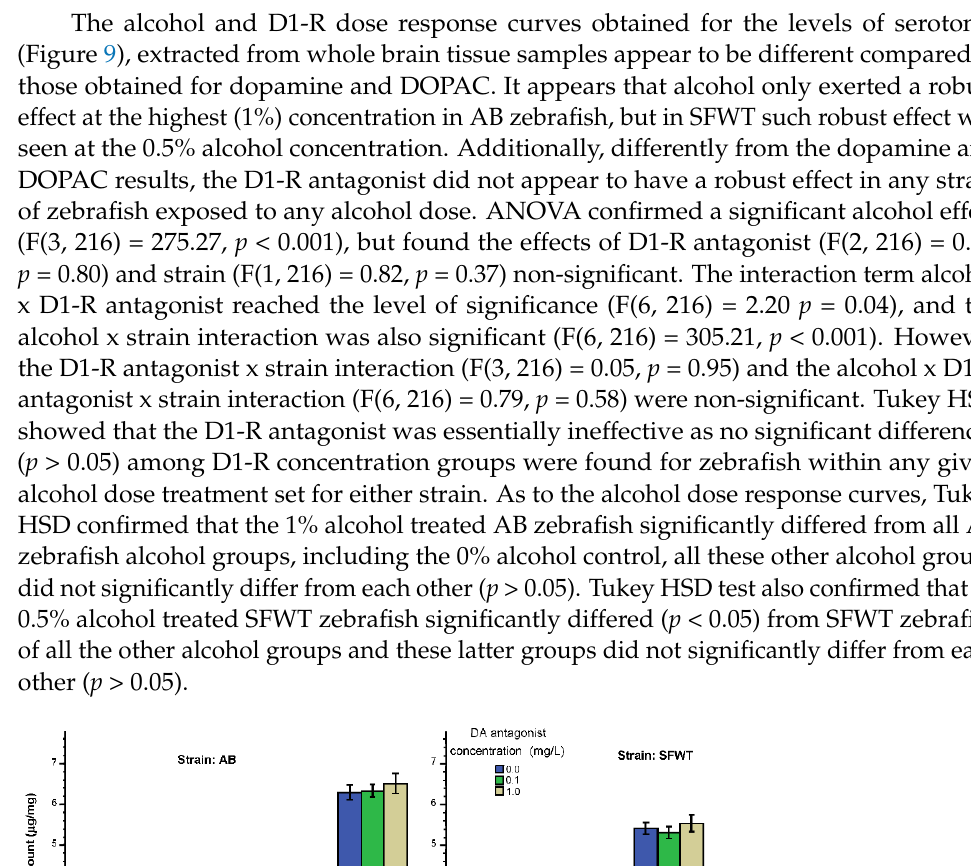
Figure 8. DOPAC levels relative to total brain protein weight are influenced by the concentration of acute alcohol (X-axis) and the concentration of acute D1-R antagonist (legend) in an interactive manner. Additionally, note the significant strain difference. Mean ± S.E.M. are shown.